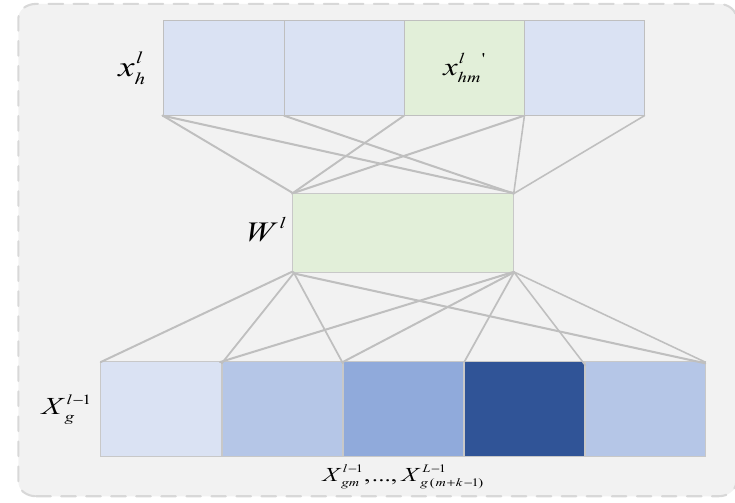
Figure 3. Schematic diagram of one-dimensional convolution.